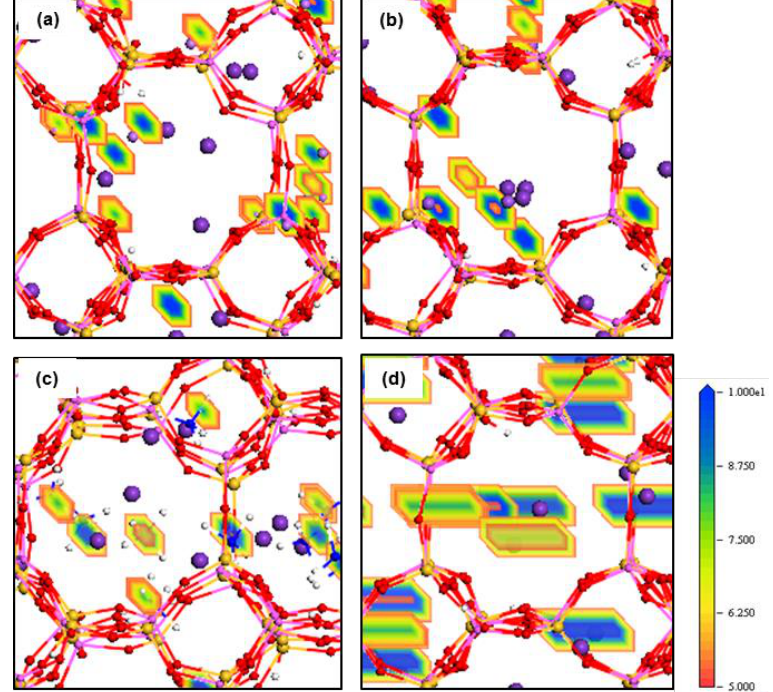
Figure 5. Density field maps of M n ⁺ guest cations in ( a ) K⁺/Li⁺, ( b ) K⁺/Na⁺, ( c ) K⁺/NH 4 ⁺ and ( d ) K⁺/Cs⁺ systems retained inside ZM-110 after 8.5 ns MD simulations.